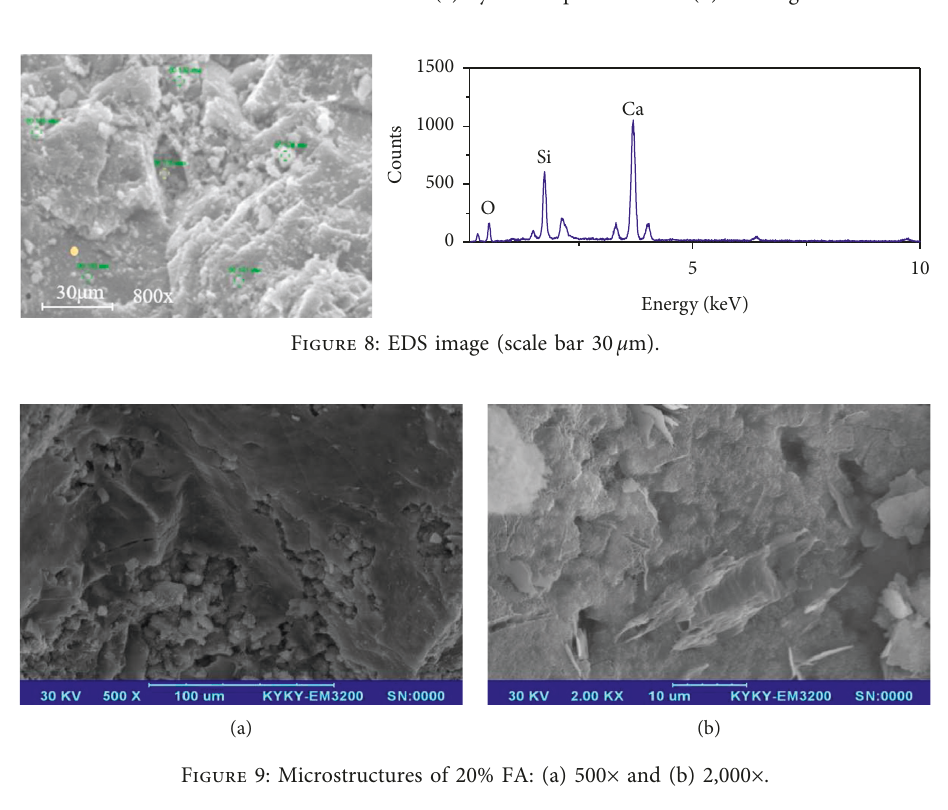
Figure 7: Microstructures of 0% FA: (a) hydration products and (b) C-S-Hgelation.